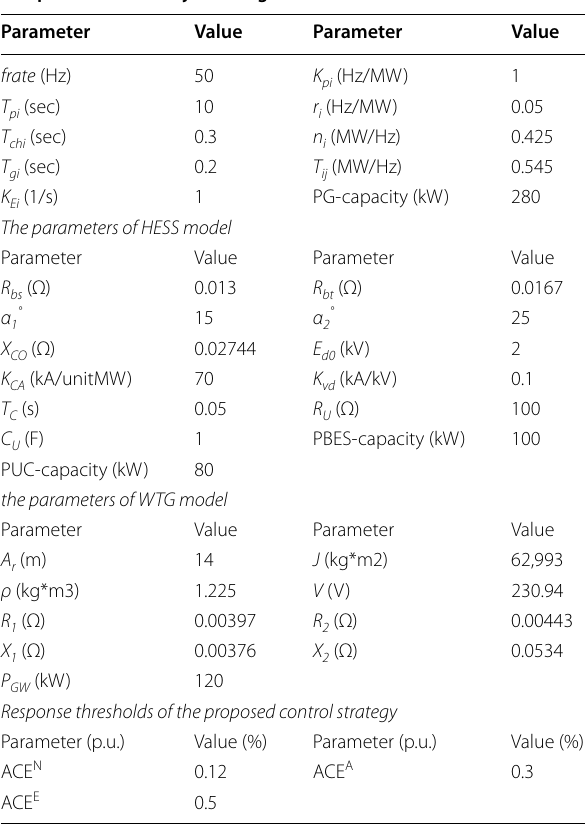
Table 2 The part model parameters and control system